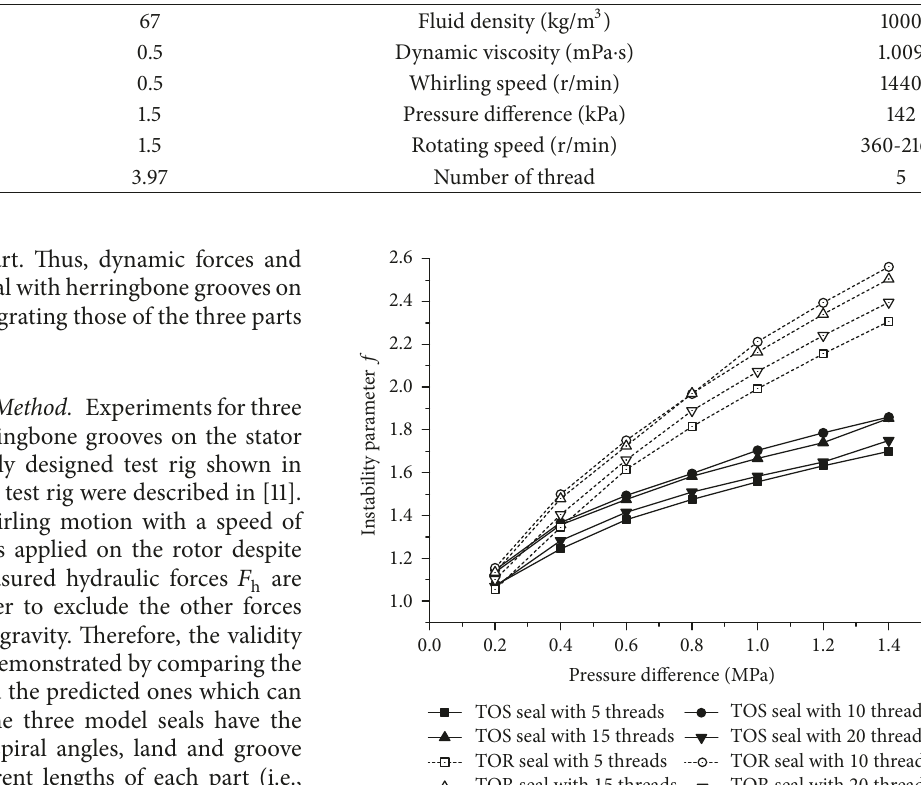
Table 2: Operating conditions and geometric parameters of the tested HGLSs.